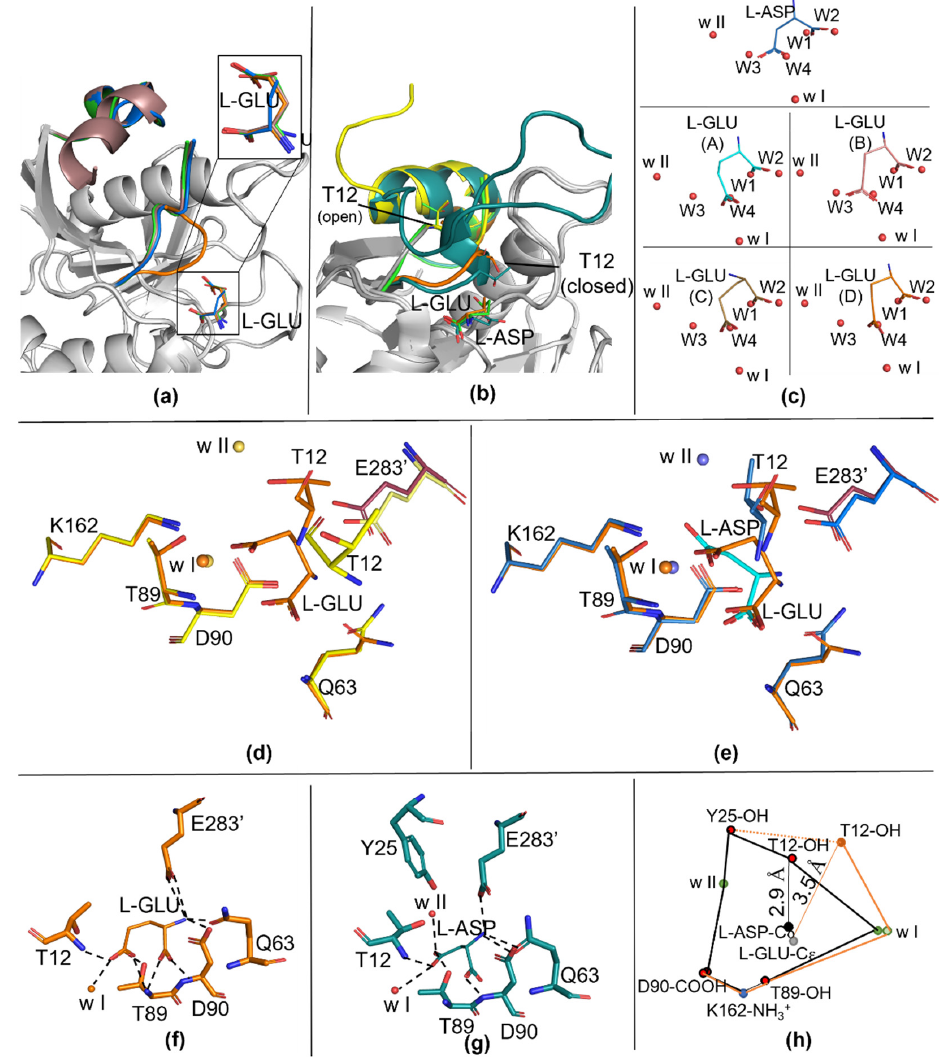
Figure 1. Details of the catalytic site of apo ‐ N24S (7R59) and N24S–GLU (7R5Q). ( a ) N24S–GLU protomers superposition with details of L ‐ GLU conformation (top right rectangle). The active site flexible loop (ASFL) is represented as a cartoon and colored in blue for protomer A, dark pink for protomer B, green for protomer C and orange for protomer D. ( b ) Details on the ASFL organization in apo ‐ N24S (PDB ID: 7R57, yellow), in N24S–ASP (PDB ID: 5MQ5, dark green) and in N24S–GLU (PDB ID: 7R5Q: green, protomer C in its open conformation; orange, protomer D in its closed conformation). The products (L ‐ ASP and L ‐ GLU) and the catalytic T12 residue are represented as sticks, ASFL is represented as a cartoon. ( c ) Water molecules displacement in the substrate ‐ binding pocket. L ‐ ASP and L ‐ GLU are represented as sticks. Water molecules are represented as red spheres. Waters present in the apo ‐ N24S structure and replaced by the product in the ligand ‐ bound structures are named W1 to W4; highly conserved, catalytic waters are named w I and w II. Top panel: ligand in N24S–ASP. Bottom panel: ligand in the four protomers of N24S–GLU. ( d , e ) Comparison of catalytic centers: in ( d ), apo ‐ N24S (yellow) and N24S–GLU (orange), in ( e ), N24S–ASP (dark green) and N24S–GLU. Products and catalytic residues are represented as sticks, waters are represented as spheres. ( f , g ) L ‐ GLU and L ‐ ASP polar contacts. ( h ) Distances of catalytically relevant chemical groups in N24S–ASP (black lines) versus N24S–GLU (orange lines). The connection between Y25 and T12 in N24S–GLU is represented as a dotted line, as Y25 could not be modelled in the N24S–GLU structure.